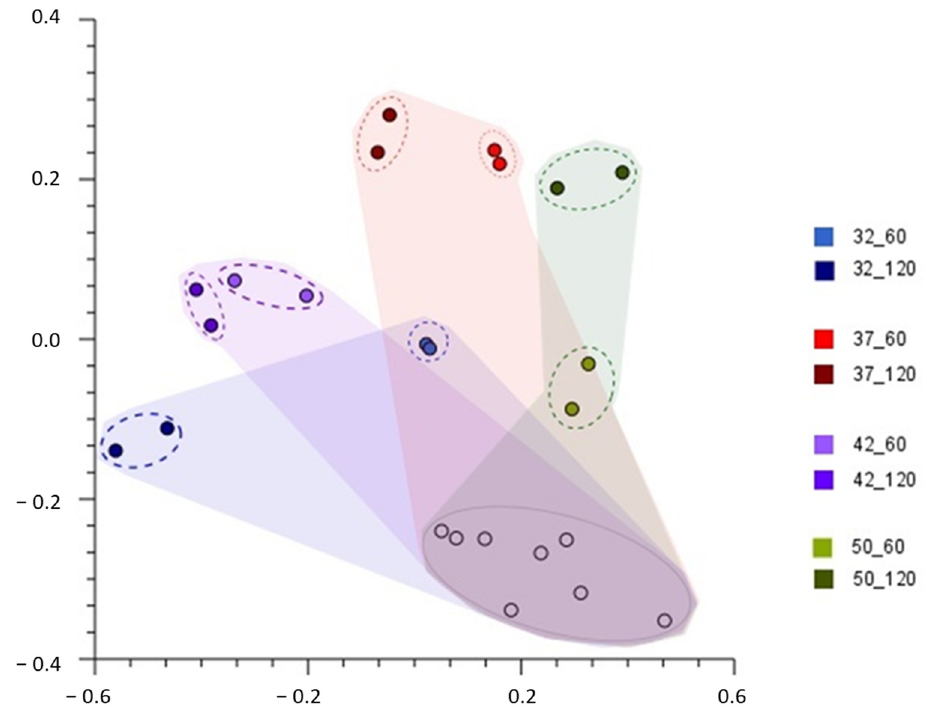
Figure 2. Principal component analysis plot of bacterial communities at the phylum level. Whey samples were fermented by their native microbiota at 32, 37, 42 and 50 °C for 0, 60, and 120 h. Non-colored circles correspond to unfermented fresh whey samples.